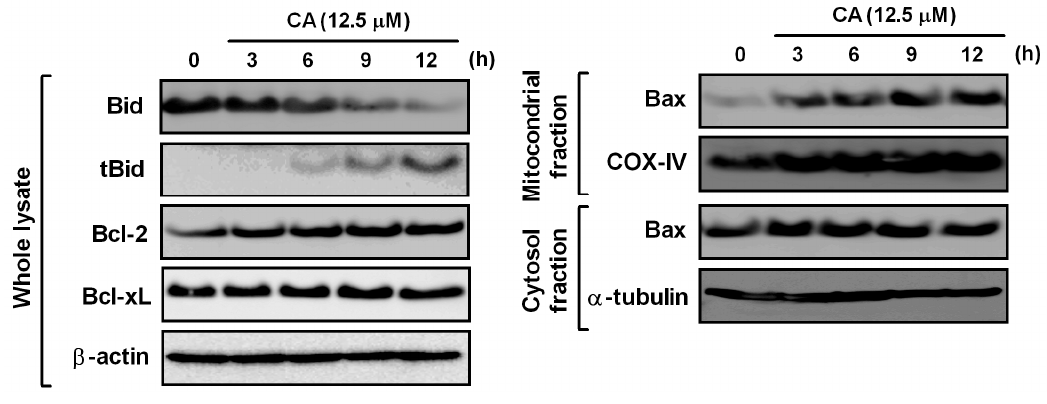
Figure 7. Effect of CA on Bcl-2 family proteins. HL-60 cells were treated with 12.5 μ M CA for the times indicated. Whole cell lysates and mitochondrial and cytosolic fractions were prepared, and the levels of each protein were determined by Western blotting. β -actin, COX-IV and α -tubulin were used as the loading controls for the whole cell lysate, mitochondrial fraction and cytosolic fraction, respectively. The data shown are representative of three independent experiments with similar